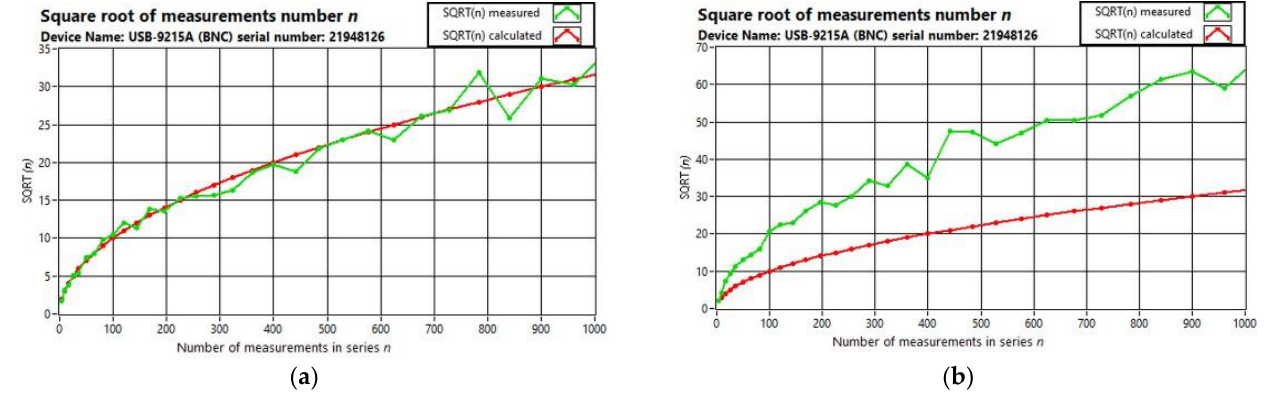
Figure 15. The ratio of the experimental standard deviation in a single result in a series to the experimental deviation of the mean value of a series of n measurements compared to the root of the number of measurements for the tested module NI USB-9215: ( a ) at low interference level, ( b ) at high interference level.